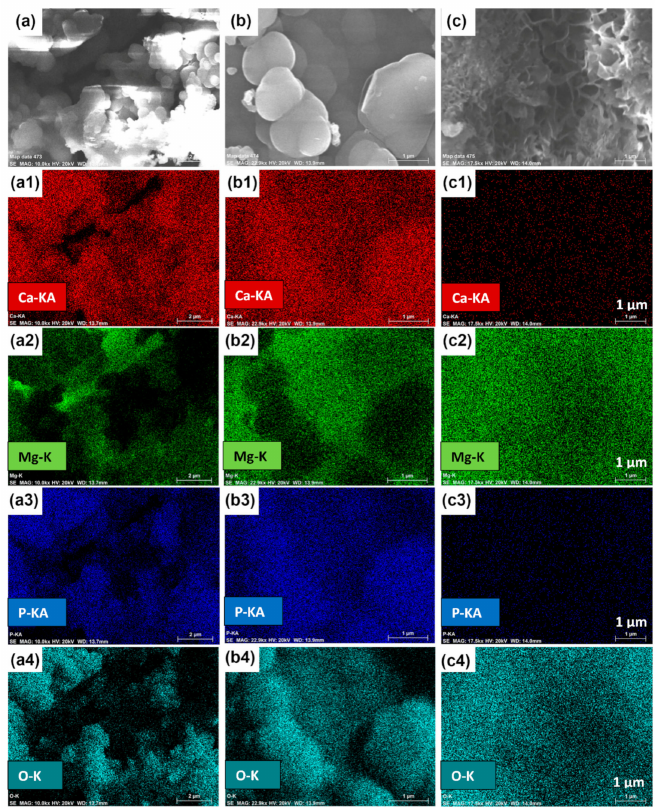
Figure 11. EDS elemental mapping showing the bioactivity response of ( a – a4 )